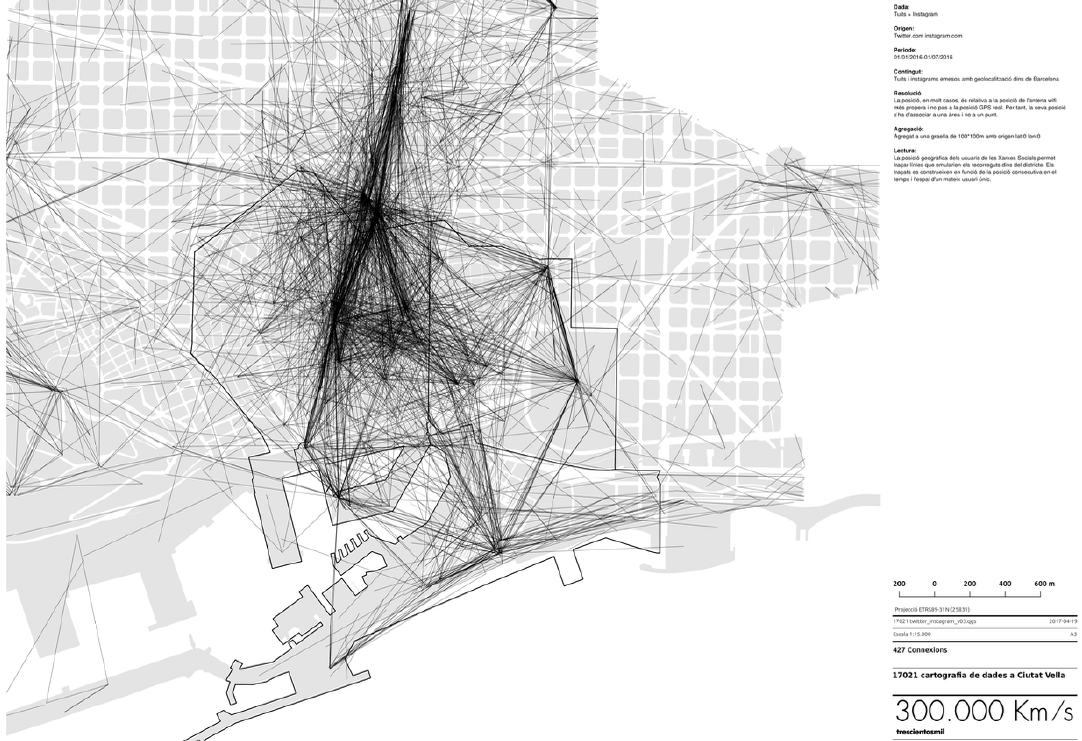
Figure 10. Circuit of people moving in CVD marks La Rambla as main axis of mobility. Source: Trescientosmil kms